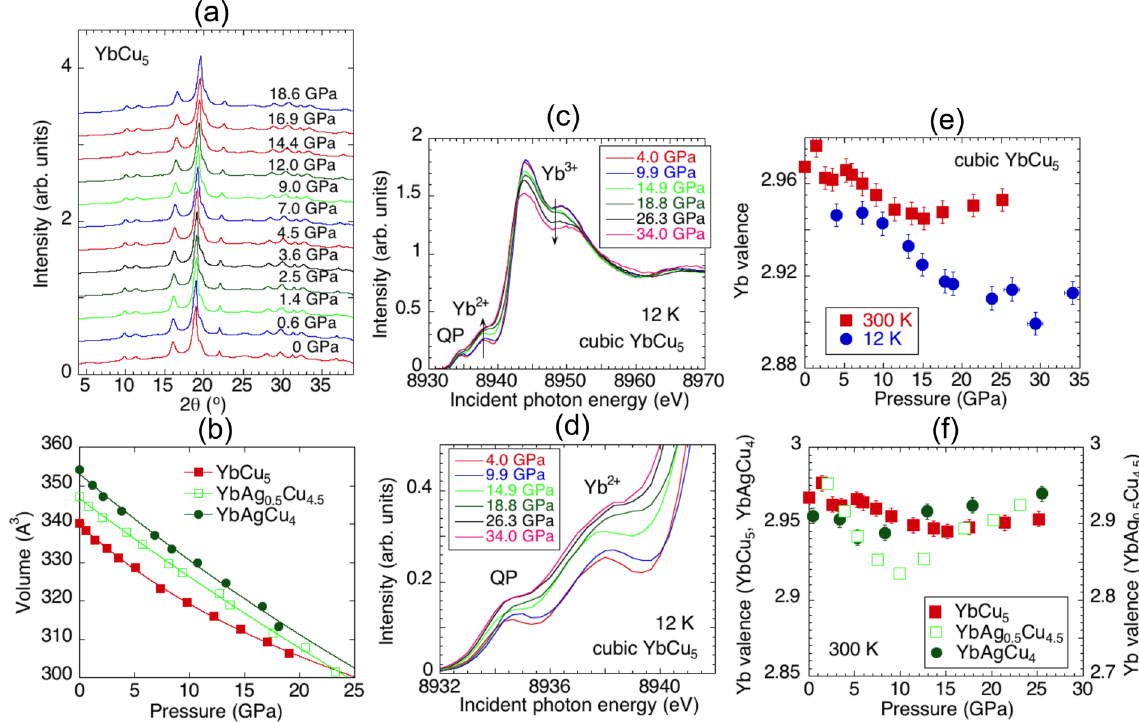
Figure 2. The experimental results of cubic YbAg x Cu 5 − x ( x = 0, 0.5, and 1.0) at 300 K are shown. ( a ) X-ray diffraction patterns measured with λ = 0.6888 Å for YbCu 5 . ( b ) Pressure dependence of the volume for YbAg x Cu 5 − x ( x = 0, 0.5, and 1.0). Solid lines are fits with the equation of state. ( c ) Pressure dependence of PFY- XAS spectra at 12 K for YbCu 5 . ( d ) Enlarged view of ( c ) for the quadrupole (QP) and Yb 2 + components. ( e )